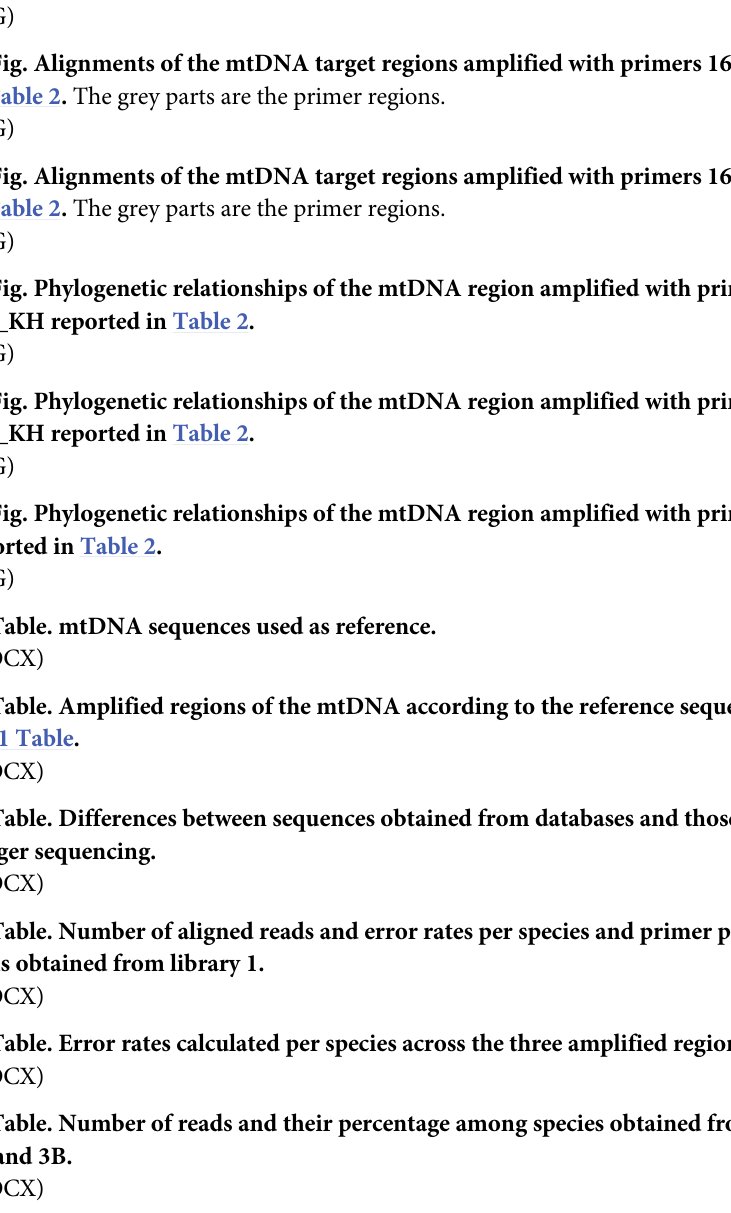
S4 Table. Number of aligned reads and error rates per species and primer pair combina- tions obtained from library 1. S5 Table. Error rates calculated per species across the three amplified regions. S6 Table. Number of reads and their percentage among species obtained from libraries